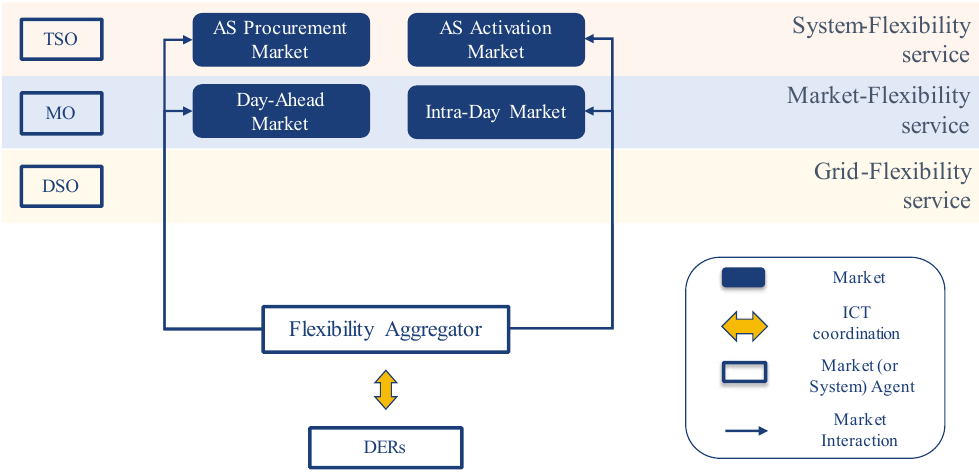
Figure 3. First stage: the aggregator should be enabled to interact with already established short-term markets to provide market services and system